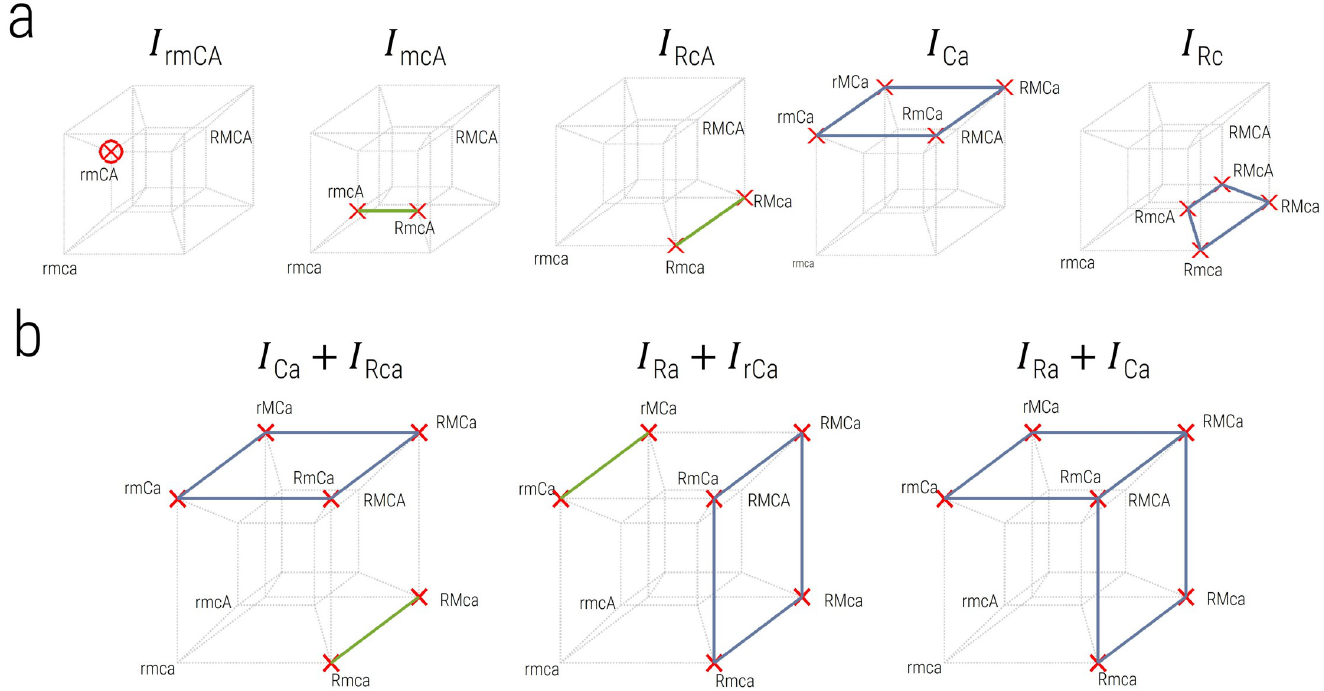
Fig 4. Decomposition of hybrid DMIs on a Boolean hyper 4-cube. Each point on the 4-cube represent each possible hybrid genotype across 4 loci, including the genotype of each parental lineage, where each red cross represents an incompatible hybrid genotype. As shown in a) the fundamental types of DMIs, where a blue square or face identify a subspace of genotypes that correspond to a 2-way DMI, a single green edge or line corresponds to a 3-way DMI and a red open circle corresponds to a single isolated 4-way DMI. b) A more complicated pattern of hybrid DMIs and their decomposition into fundamental types.